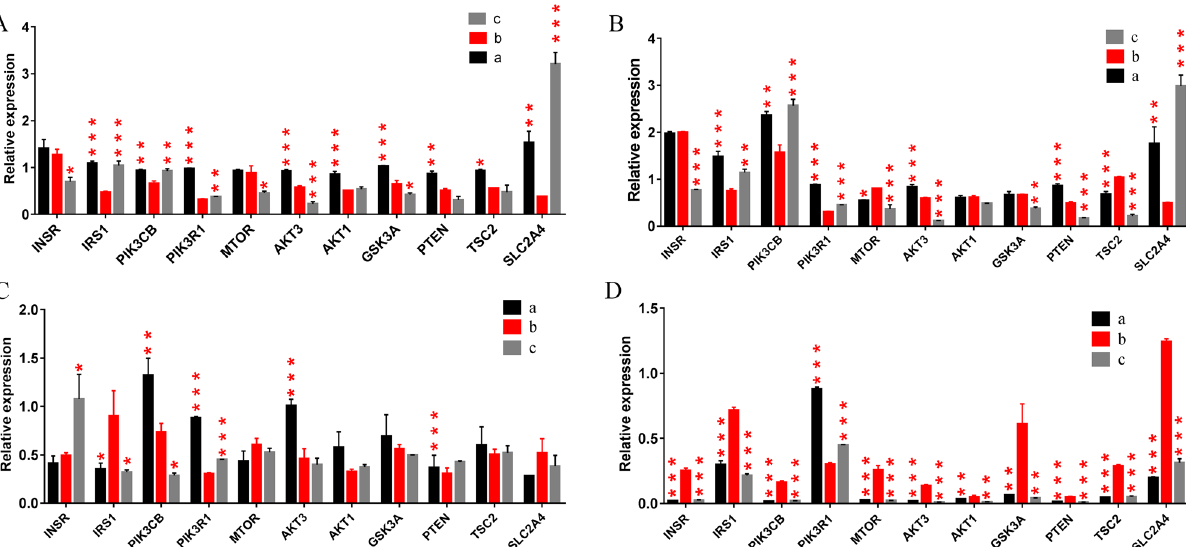
Figure 2. qRT-PCR results for genes in tissues of Bactrian camels reported as relative expression. a: feeding period, b: fasting period, c: recovery feeding period. ( A ) Fore hump, ( B ) hind hump, ( C ) subcutaneous fat, ( D ) biceps femoris muscle. Statistical determinations were made using one-way ANOVA (* p < 0.05, ** p < 0.01, *** p < 0.001). Red asterisks indicate significant differences compared to